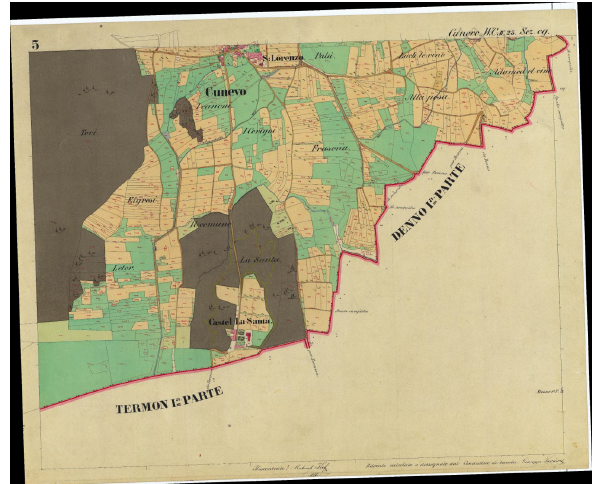
Figure 1. Map sheet 22 05 of the Comune catastale di Cunevo used for the